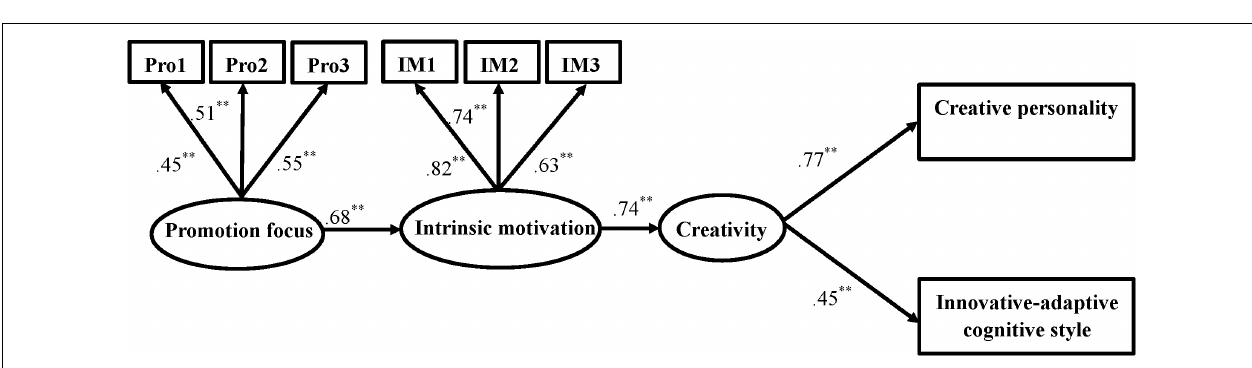
FIGURE 3 | The modified model of regulatory focus, motivation, and creativity. * *p <